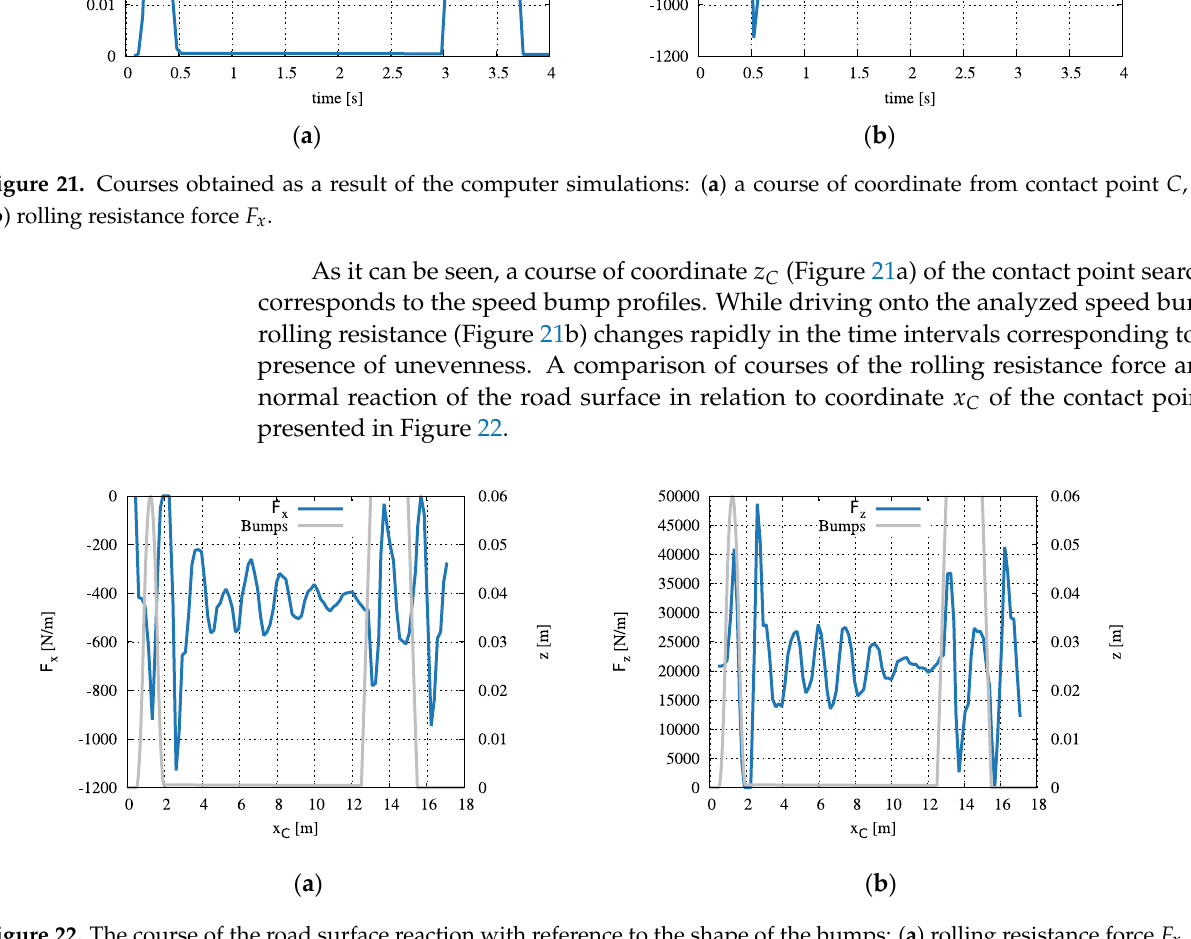
Figure 22. The course of the road surface reaction with reference to the shape of the bumps: ( a ) rolling resistance force 𝐹 𝑥 , ( b ) normal force 𝐹 𝑧 . ( b ) normal force F z